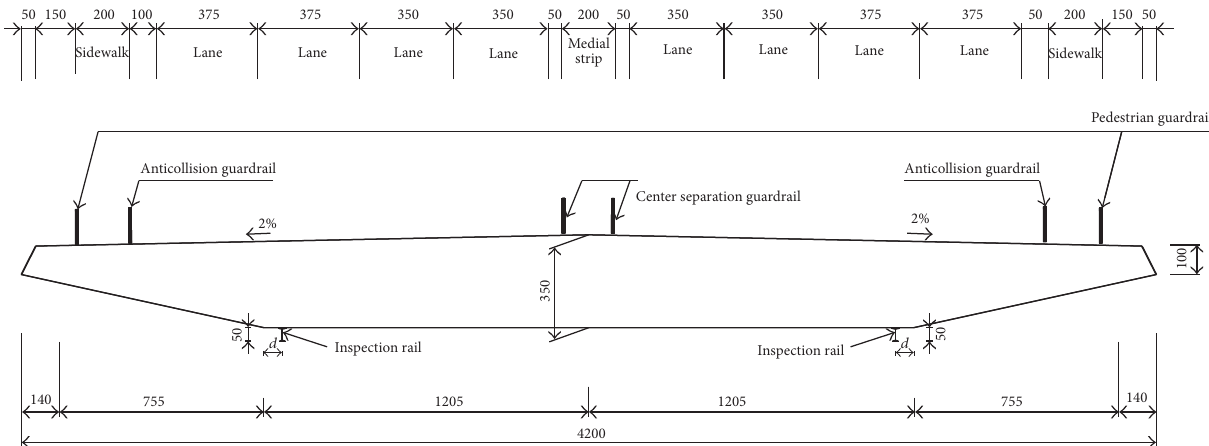
Figure 1: Geometry and dimensions of the bridge decks (unit: